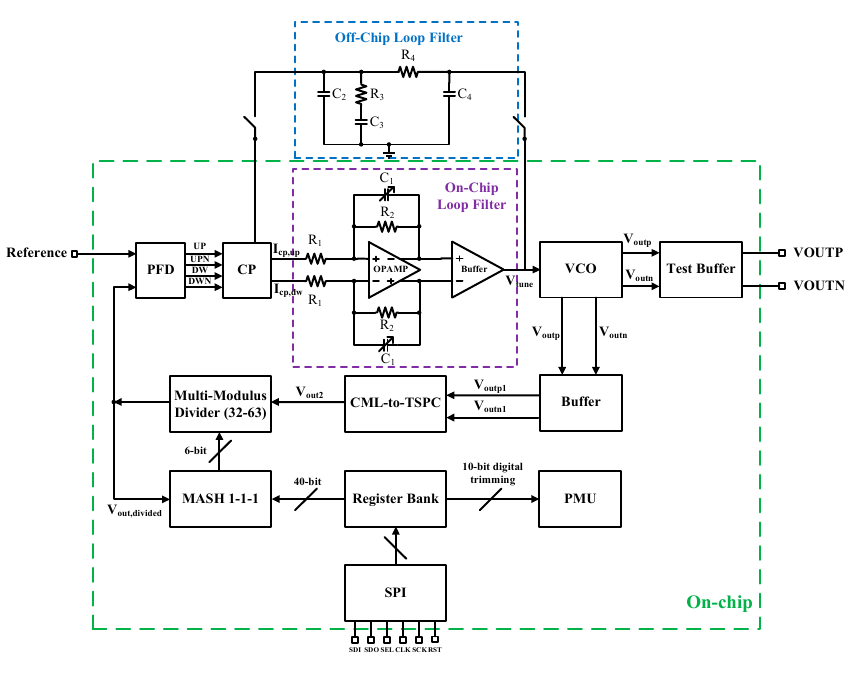
Figure 1. PLL architecture.